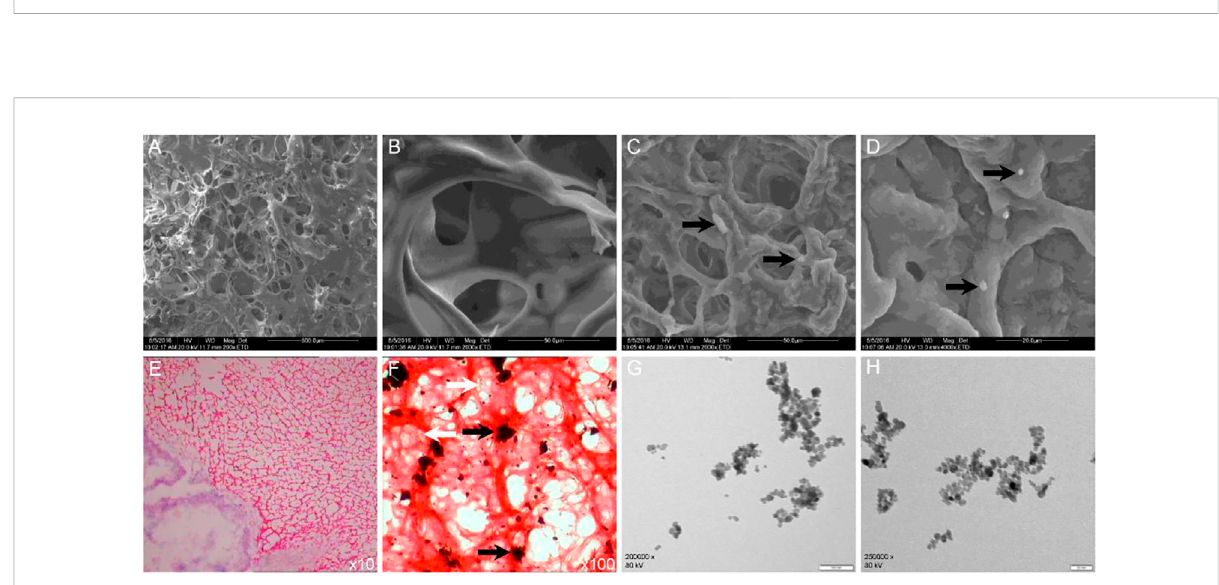
FIGURE 2 MicrostructureofCS/GPandFe 3 O 4 -THP-CS/GP. (A , B) MicrostructureoftheCS/GPgelbySEM. (C , D) MicrostructureoftheFe 3 O 4 -THP-CS/GP gel obtained by SEM. The THP granules were indicated by black arrows. (E , F) Microstructure of the Fe 3 O 4 -THP-CS/GP gel obtained by HE staining. TheTHPandFe 3 O 4 -MNPgranulesweremarkedbywhiteandblackarrows,respectively. (G , H) Transmissionelectron microscopicimagesofFe 3 O 4 - MNP at different magni fi